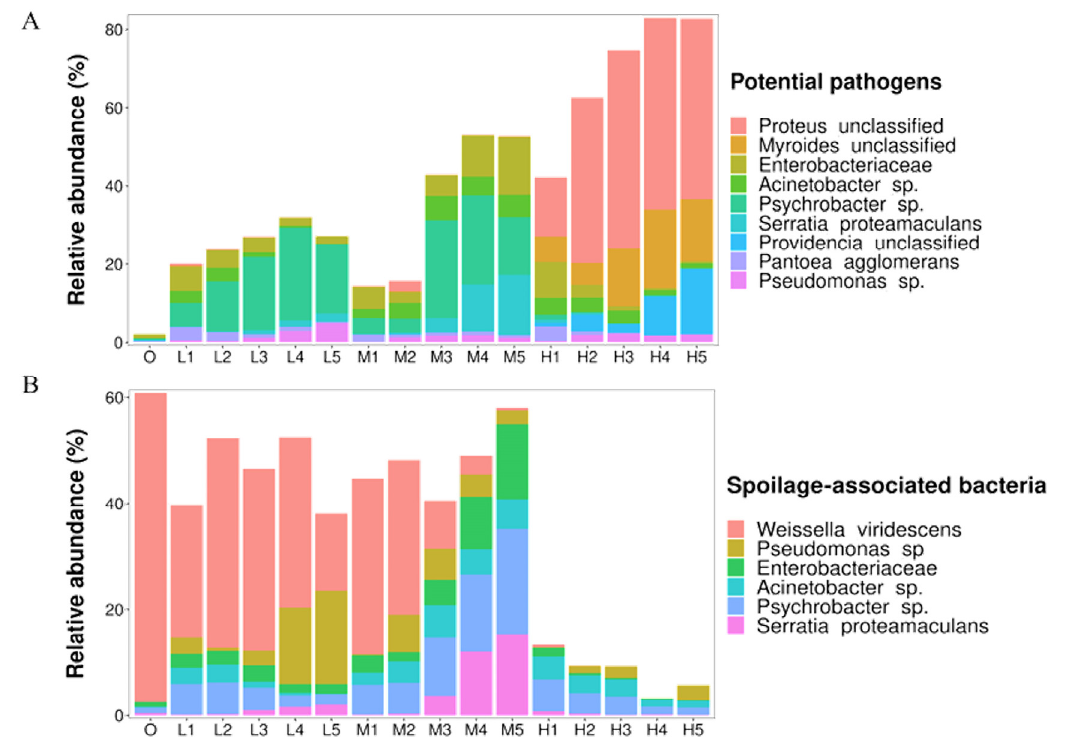
Figure 4. Relative abundance of potentially pathogenic ( A ) and spoilage bacteria ( B ).